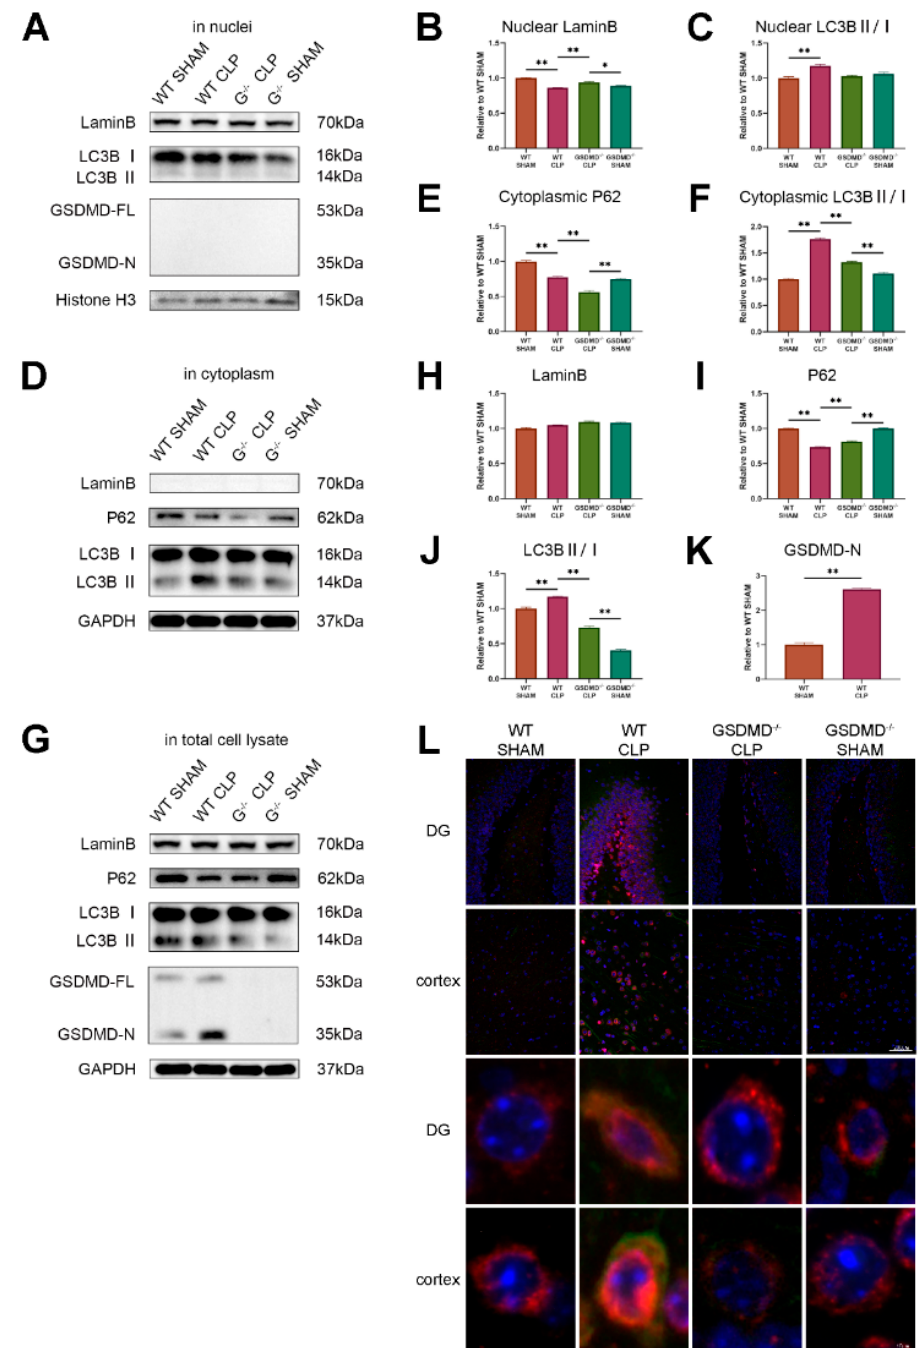
Figure 4. Digestion of LaminB caused by nuclear autophagy is independent of GSDMD. ( A ) Expres- sion of LaminB and LC3BII/I in nuclei is analyzed by Western blots. ( B , C ) Statistical analysis of Western blots of A (n = 3 per group). ( D ) Expression of P62 and LC3BII/I in cytoplasm is analyzed by Western blots. ( E , F ) Statistical analysis of Western blots of D (n = 3 per group). ( G ) Expres- sion of LaminB, P62, LC3BII/I, and GSDMD-N in whole-cell lysate is analyzed by Western blots. ( H − K ) Statistical analysis of Western blots of G (n = 3 per group). ( L ) Representative immunofluores- cence staining of LC3B, LaminB, and DAPI in the hippocampus and cortex of wild-type sham group, GSDMD − / − sham group, wild-type CLP group, and GSDMD − / − CLP group. Scale bar: 200 µ m and 10 µ m. * p < 0.05, ** p <